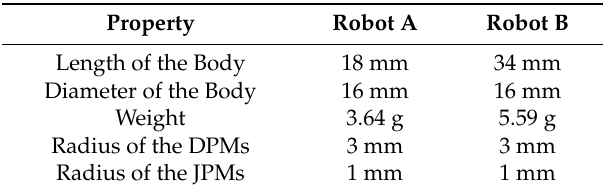
Figure 4. Fabrication of the capsule robots: ( a ) fabrication of DPMs; ( b ) fabrication of JPMs. Table 1. Parameters of the two capsule robots.